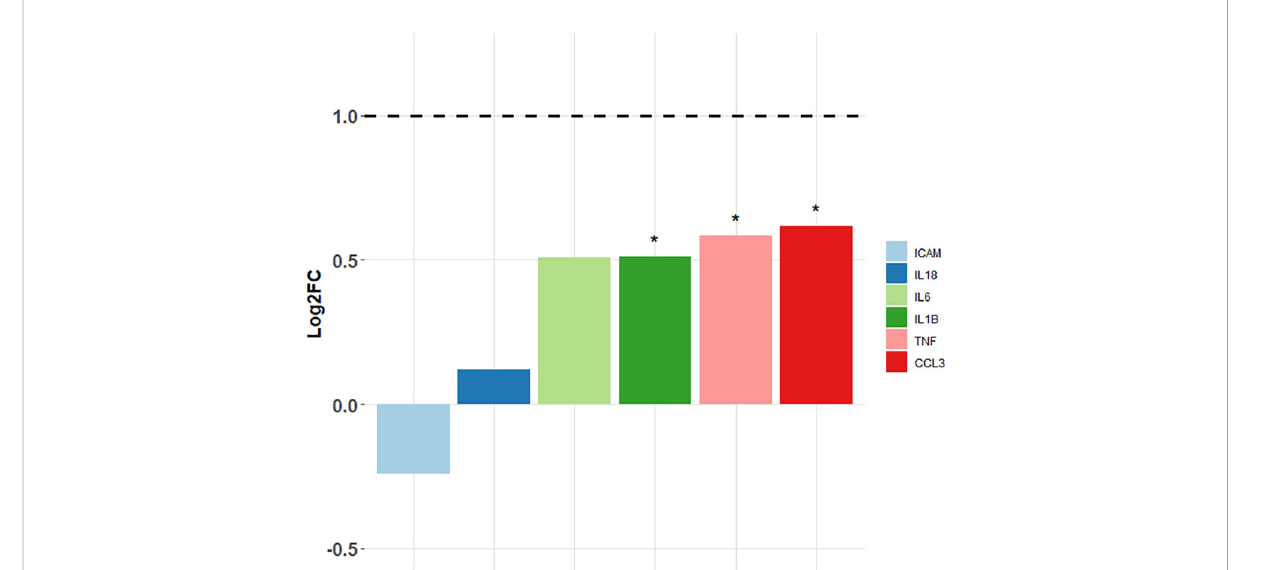
FIGURE 3 Log2FC values of the target genes measured in the sensitised rats vs. non-sensitised controls. Horizontal dashed line points to the fold change greater than 2 (i.e., log2FC ≥ 1) that was considered biologically signi fi cant. *Differentially expressed target genes (p < 0.05); ICAM — intra-cellular